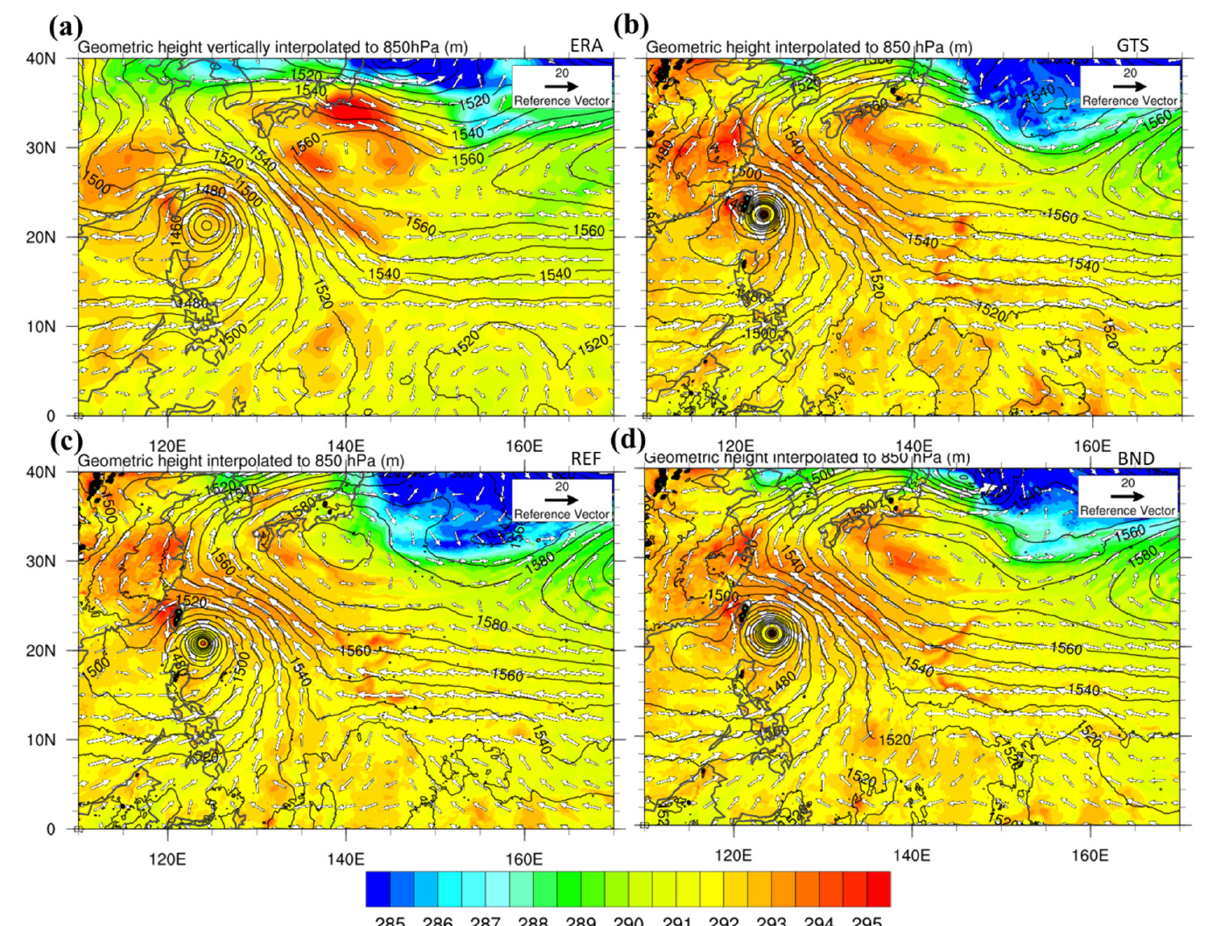
Figure 7. Geometric height (contours at an interval of 10 m), temperature (shaded in K), and horizontal wind (vectors in m s − 1 ) at 850 hPa at 0000 UTC 07 July 2016 for ( a ) ERA-Interim, ( b ) GTS, ( c ) REF, and ( d ) BND.